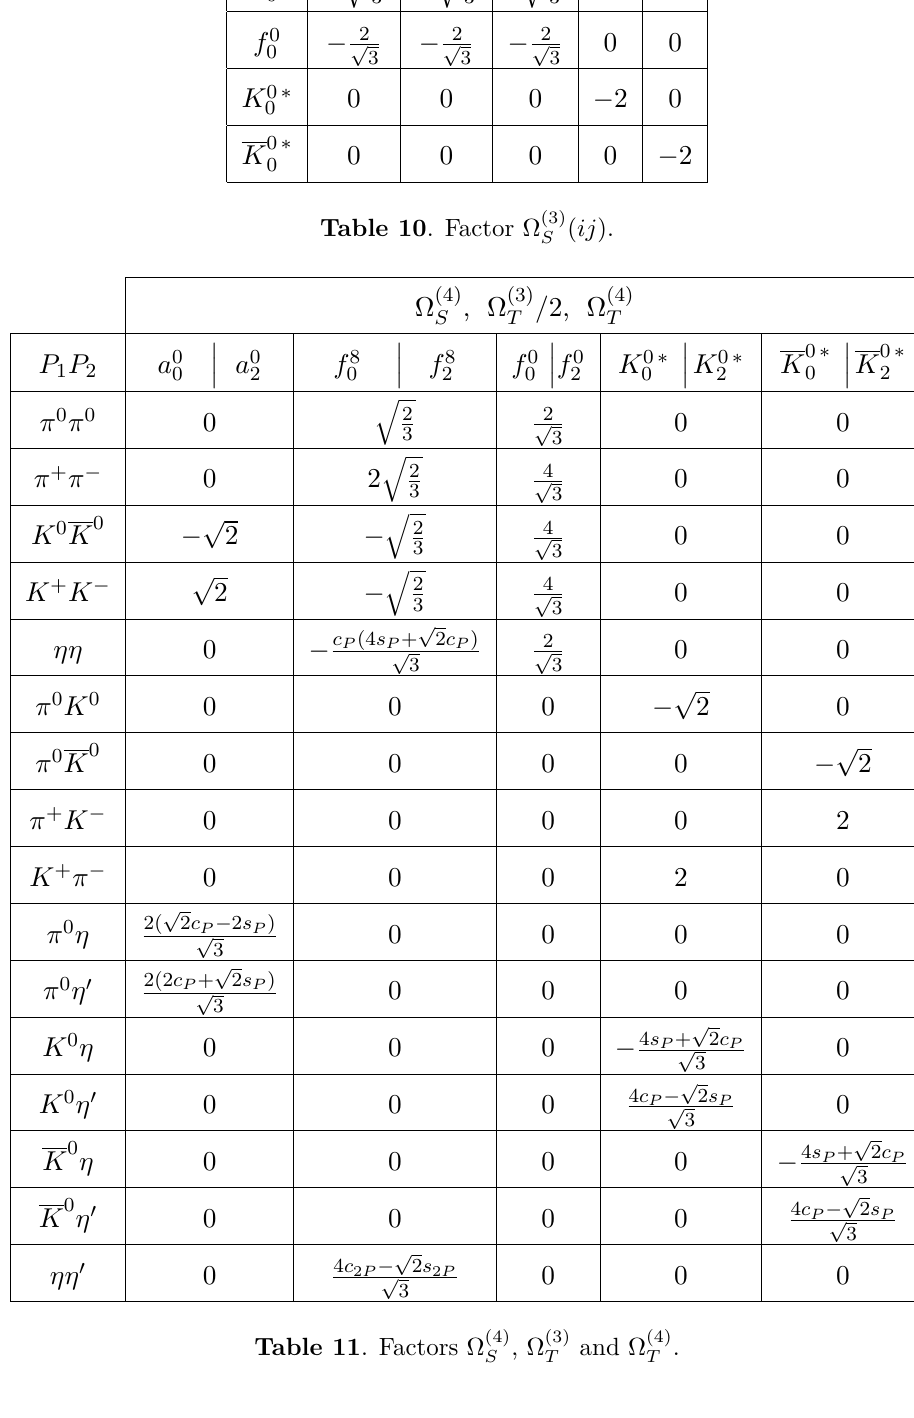
Table 11 . Factors Ω (4)